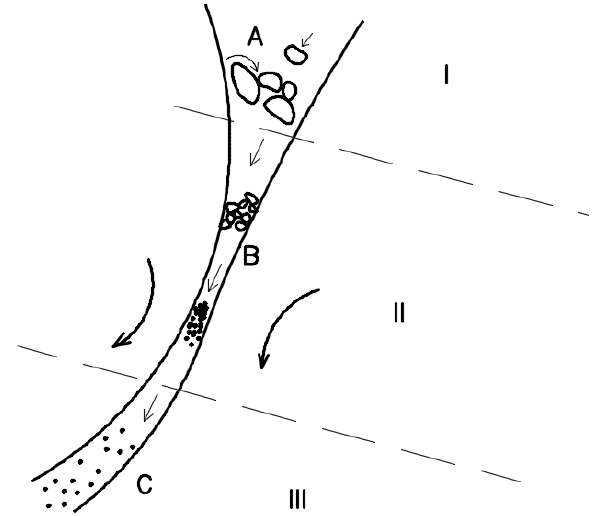
Figure 7. Diagram of the crushing process in the area of mating between the bottom of the seat and the chain link; designations: I—zone of the entry of the abrasive, II—central zone, III—exit zone, A—supply of the abrasive, B—multi-stage crushing, C—final form of crushing.